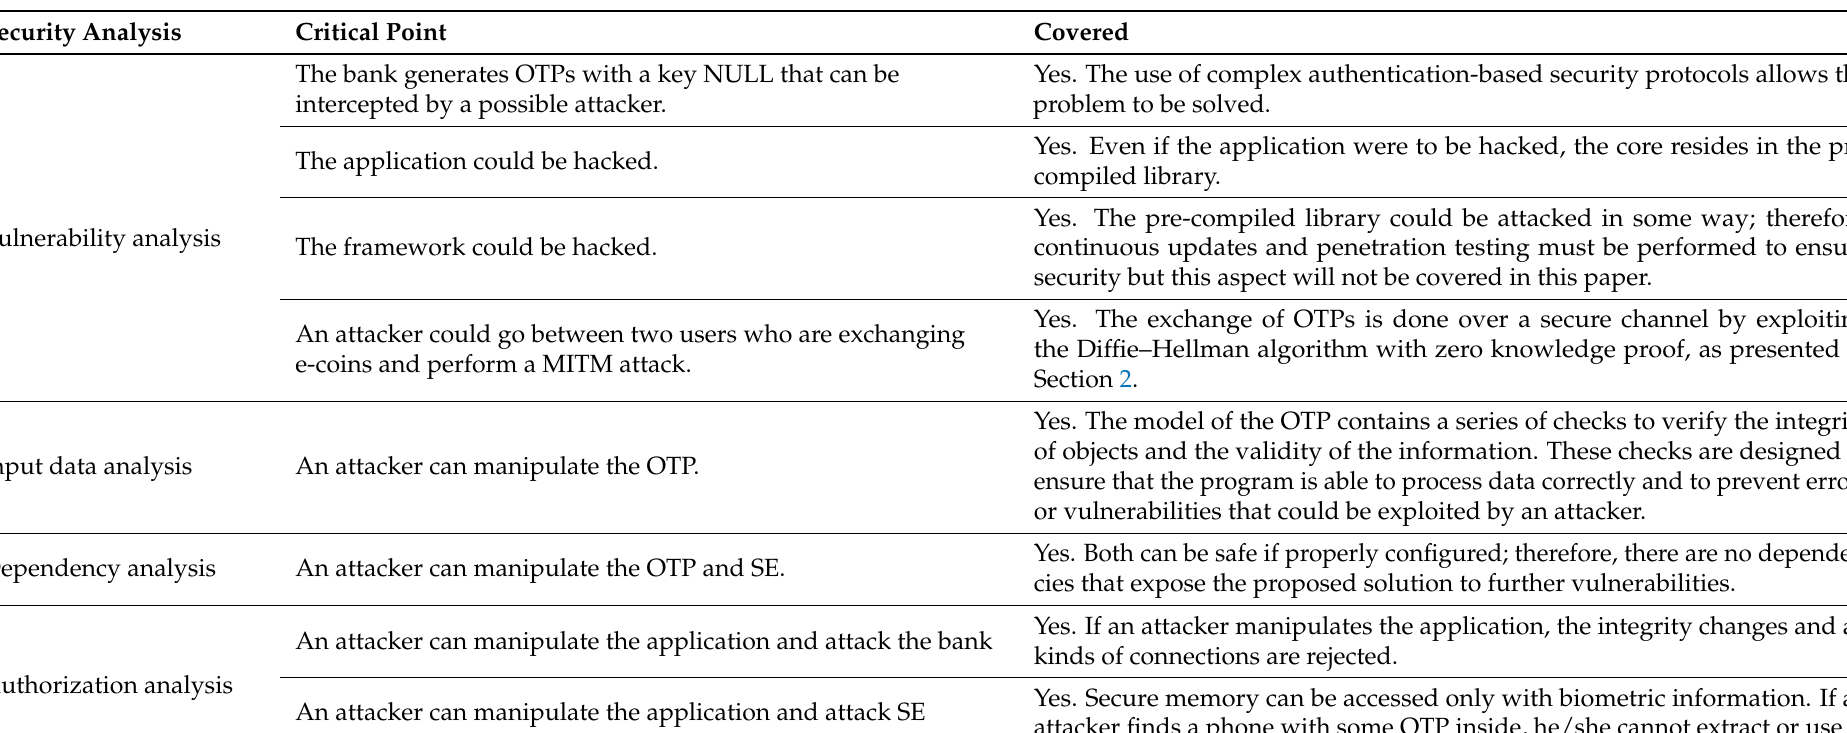
Table 2. Security